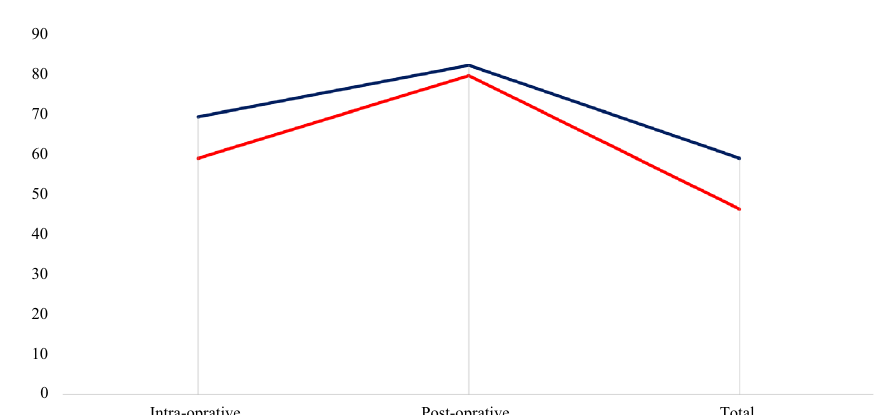
Figure 2. Percentage of patients who avoided